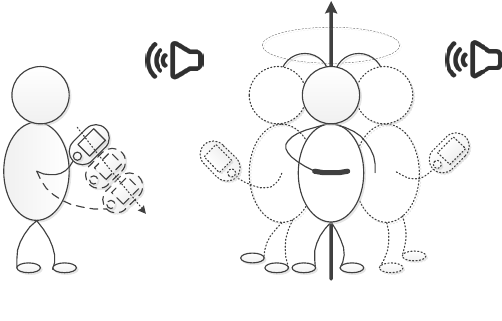
Figure 1. Virtual Uniform Linear Array and Virtual Uniform Circular Array system motion patterns of direction finding using a